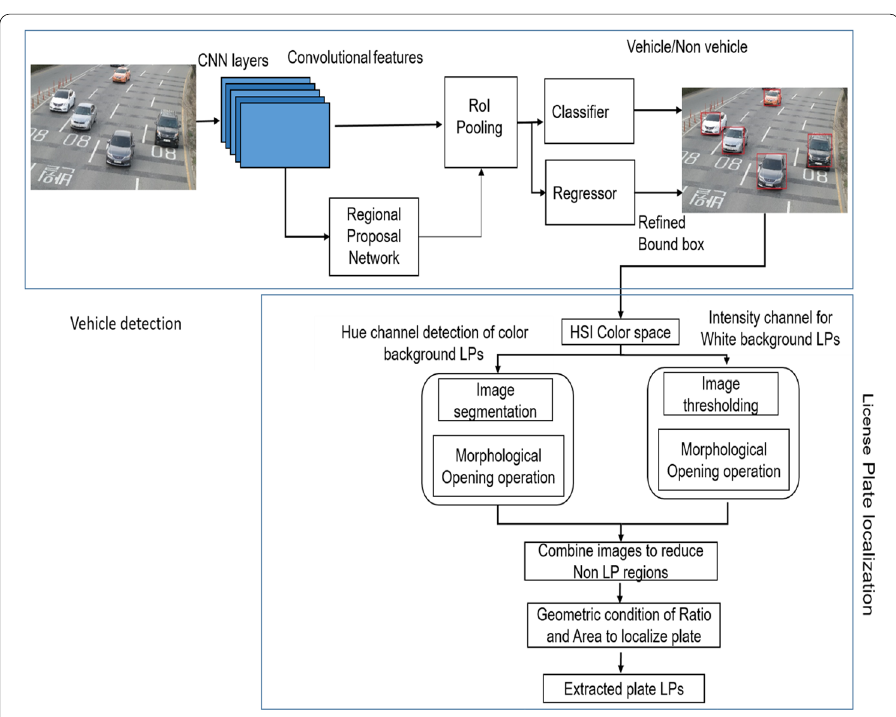
Fig. 2 Flowchart of proposed LPD’s